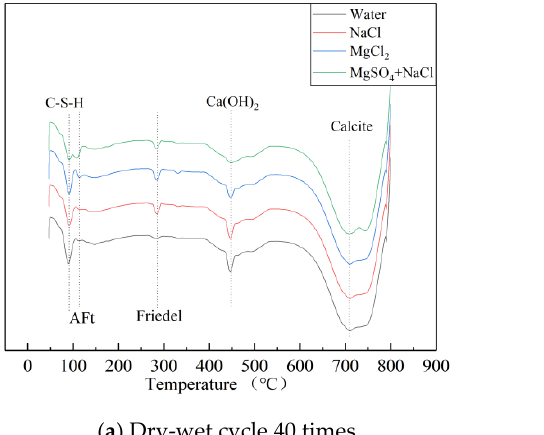
Figure 14. DTG diagram of erosion solution containing Mg 2+ .